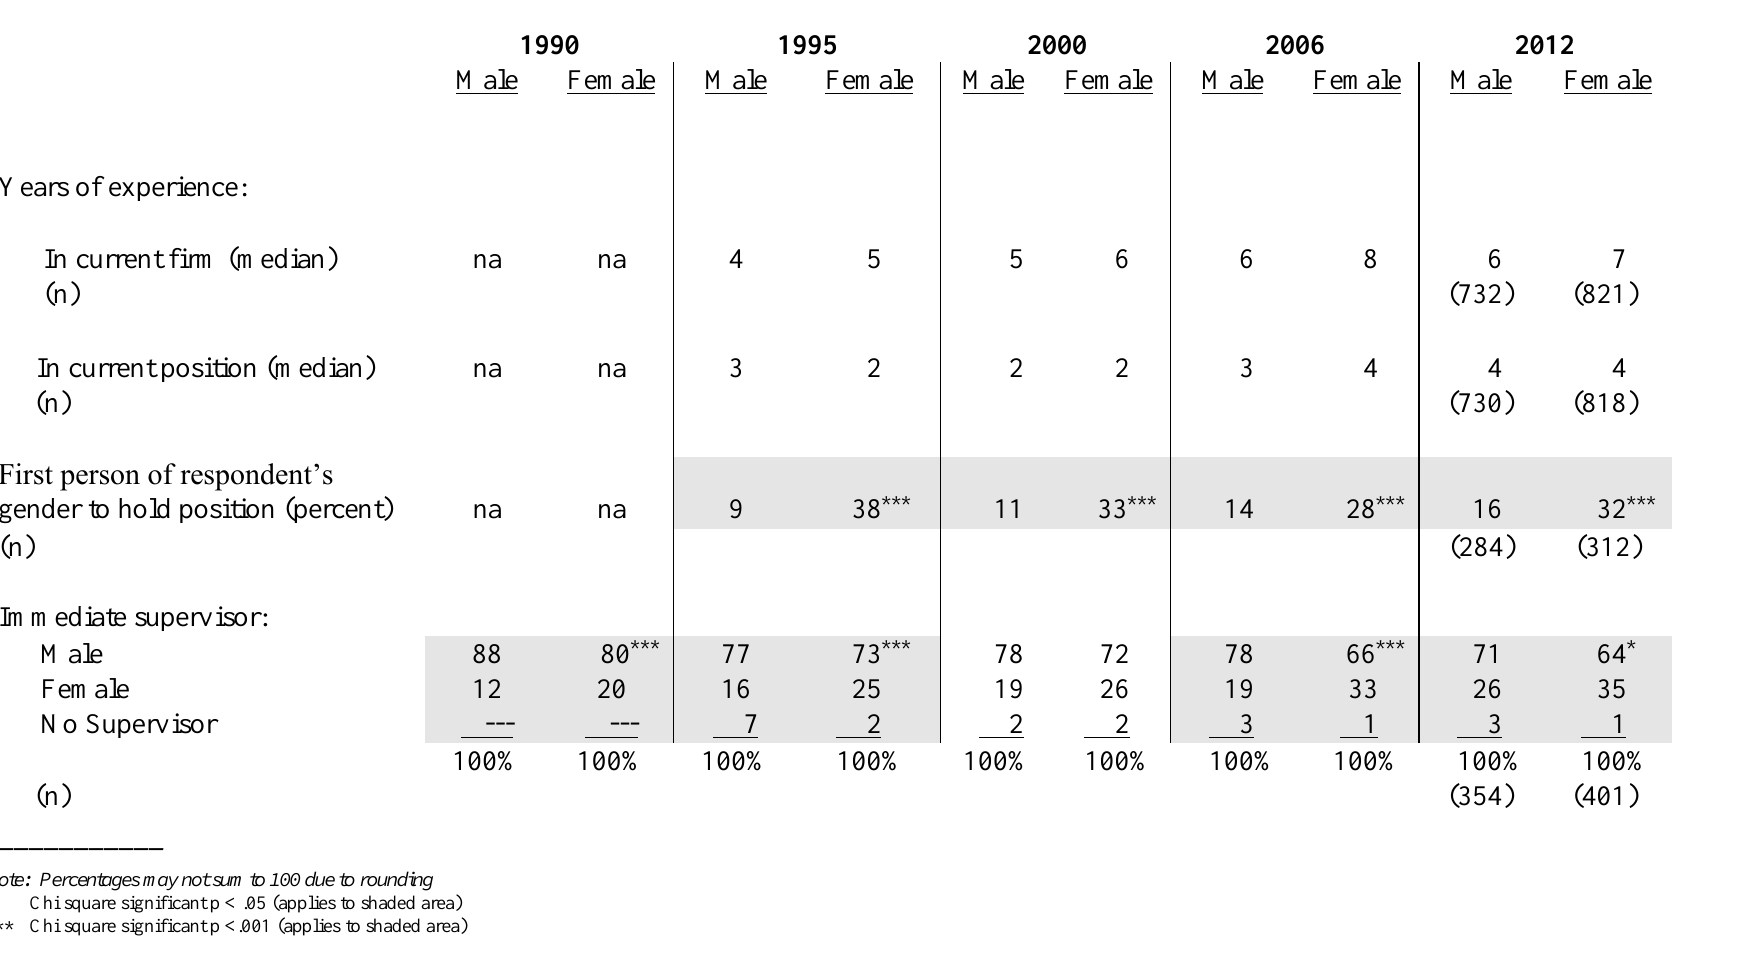
Table 6. Current Position – Related